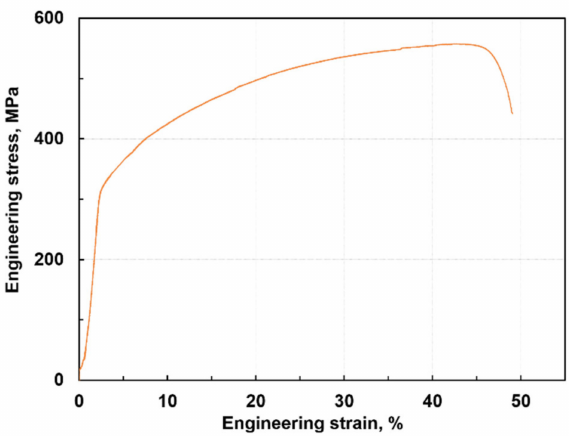
Figure 12. Load–displacement and stress–strain curves during tensile test.